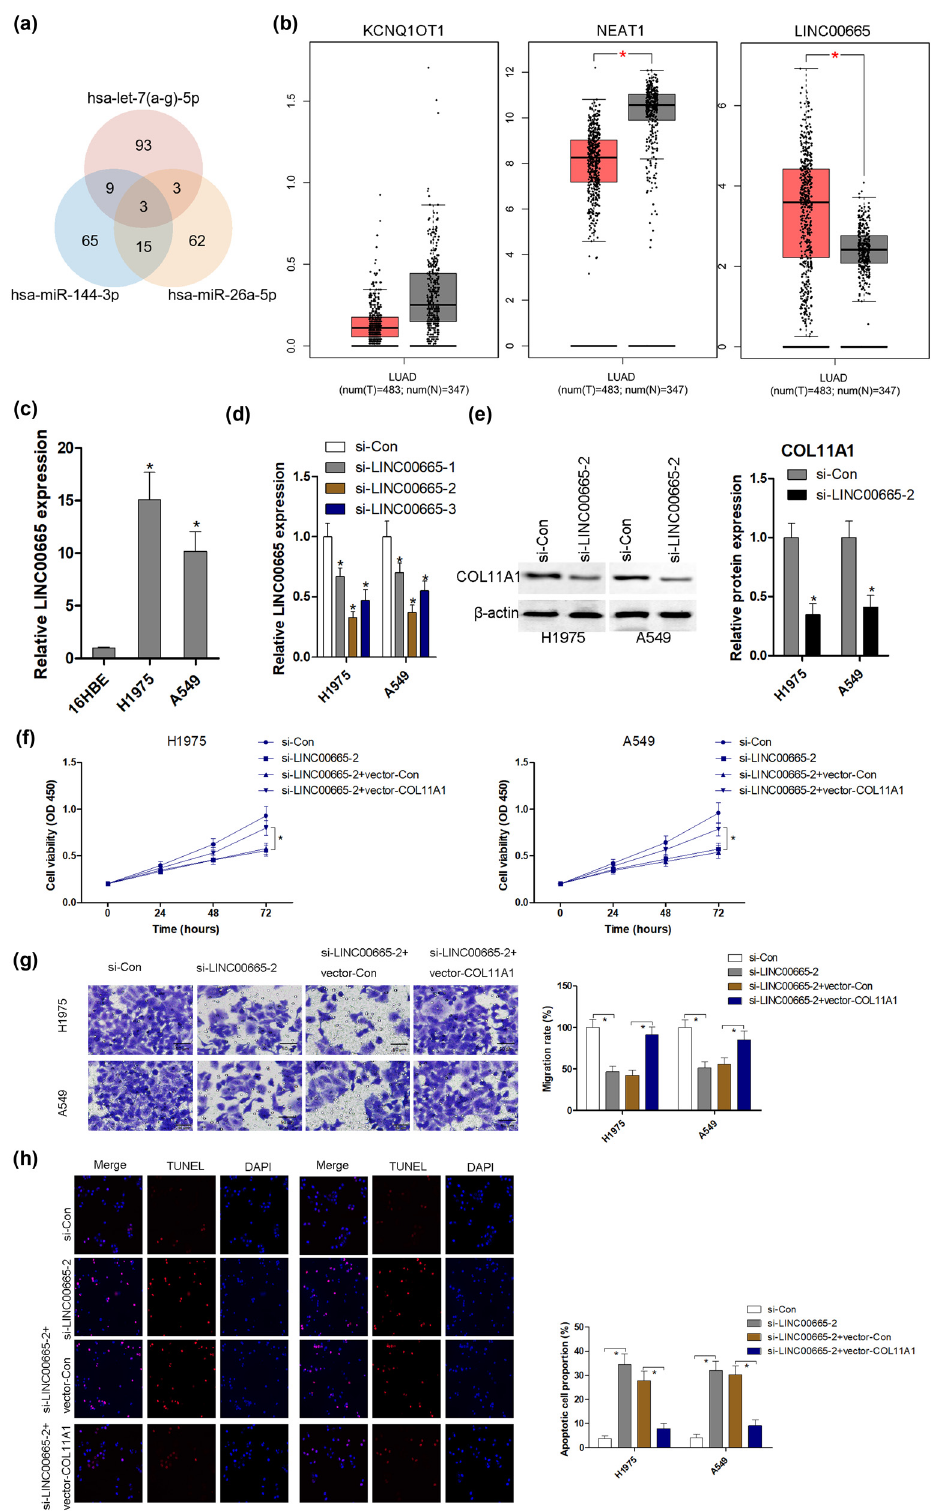
Figure 8: LINC00665 mediates COL11A1 expression in LUAD cells. The upstream lncRNAs of miRNAs was also predicted using the ENCORI database ( http://starbase.sysu.edu.cn/ ) ( a ) . The expression of three lncRNAs ( KCNQ1OT1, NEAT1 and LINC00665 ) in LUAD tissues were analyzed using the GEPIA database ( b ) . The expression level of LINC00665 was measured in H1975 and A549 LUAD cell lines ( c ) . After transfection with three di ff erent siRNAs into H1975 and A549 cells, the expression level of LINC00665 was measured using RT - qPCR ( d ) . After transfection with si - LINC00665, the protein expression of COL11A1 was measured using western blot ( e ) . After transfection with si - LINC00665, cell proliferation, migration and apoptosis were measured using CCK - 8 ( f ) , transwell ( g; magni fi cation 400 × ; scale bar = 50 μ m ) and TUNEL ( h ) assays. * P < 0.05 compared with control